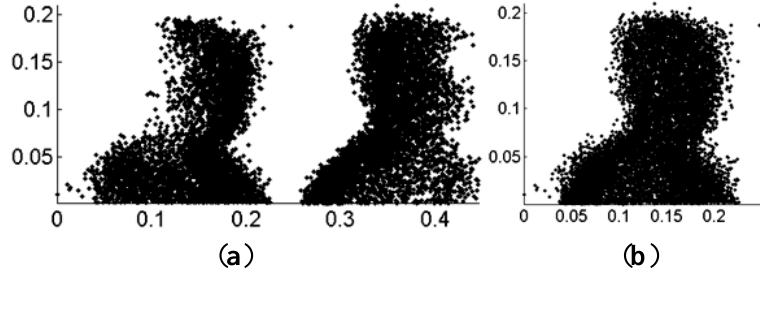
Figure 14. Registration result: ( a ) before registration; and ( b ) after